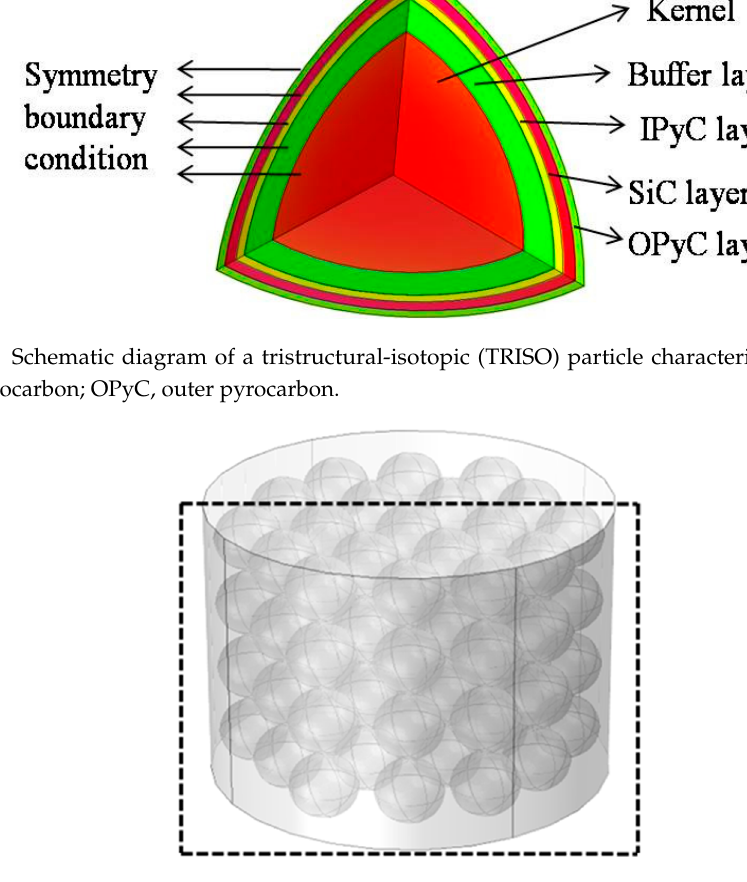
Figure 3. A three-dimensional model of a fully ceramic microencapsulated (FCM) pellet with 39.8 vol.% TRISO particle loading. TRISO particle